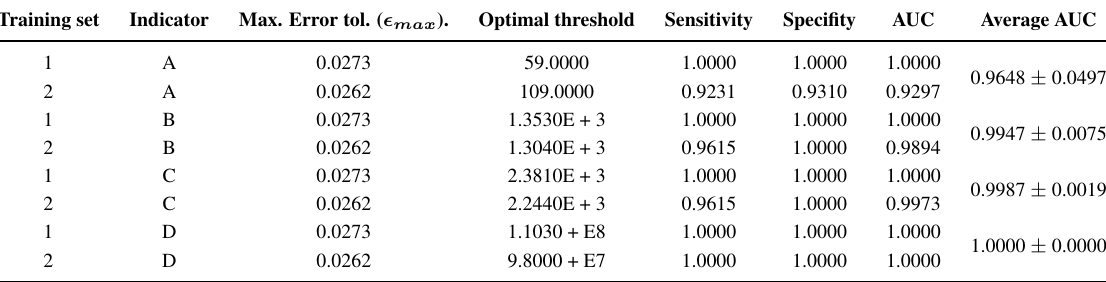
Table 1. Results of the training process of the Single-indicator Thresholding Validator. Training set Indicator